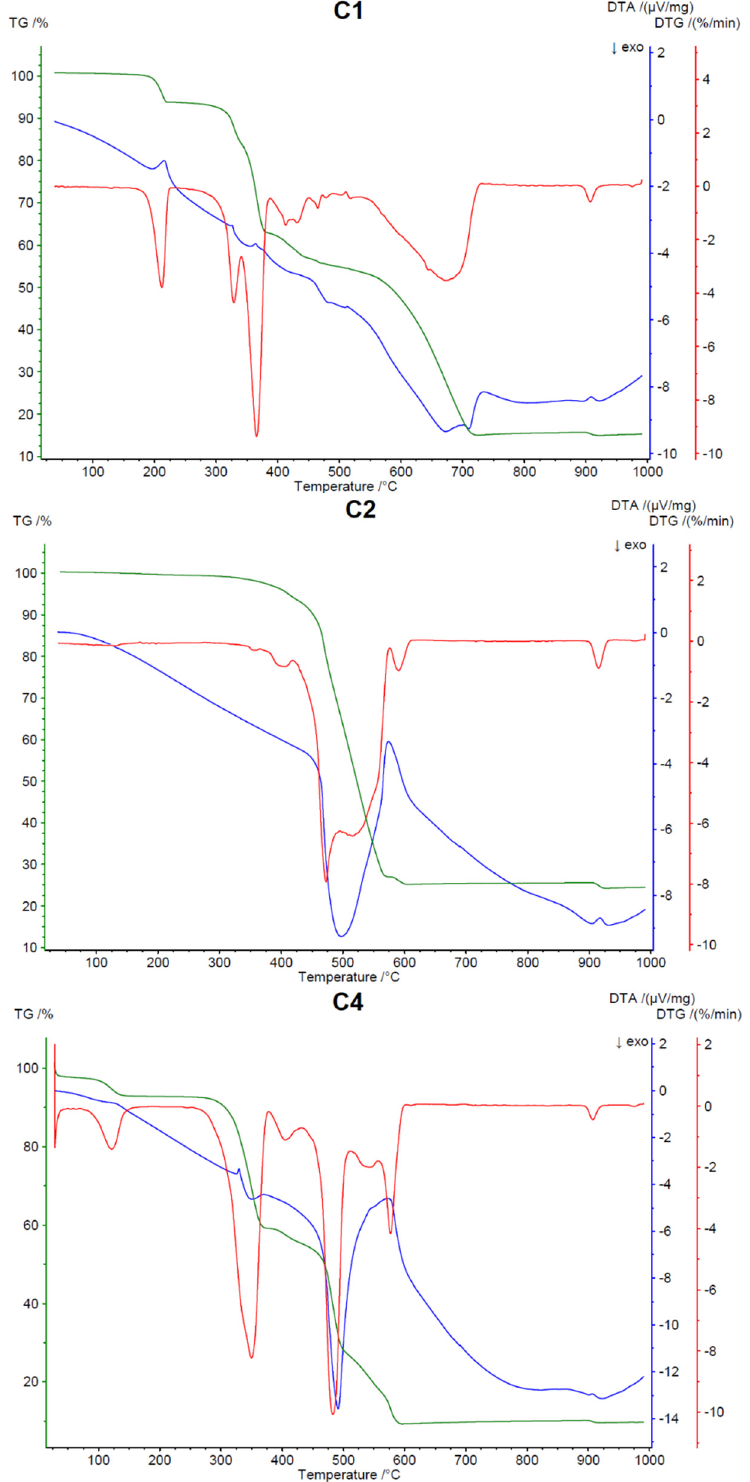
Figure 4. Thermal analyses of studied compounds C1 , C2, and C4 .